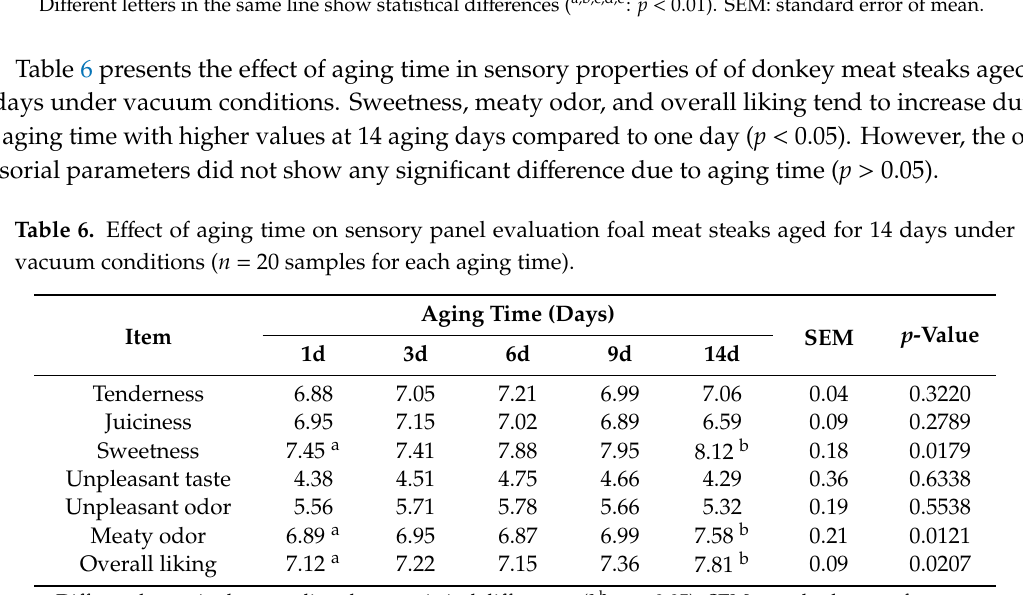
TBARs (mg MDA / kg of meat)